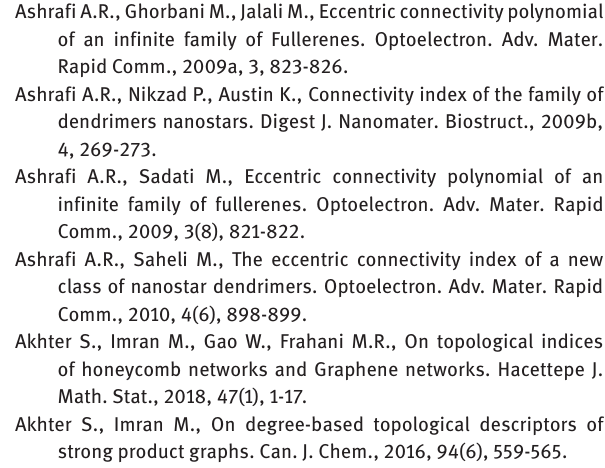
In Figure 6, comparison of first Zagreb-eccentricity index of PD[r] and second Zagreb eccentricity index of PD [r] which shows that in the given domain M 1* ( PD [r]) is more dominating.